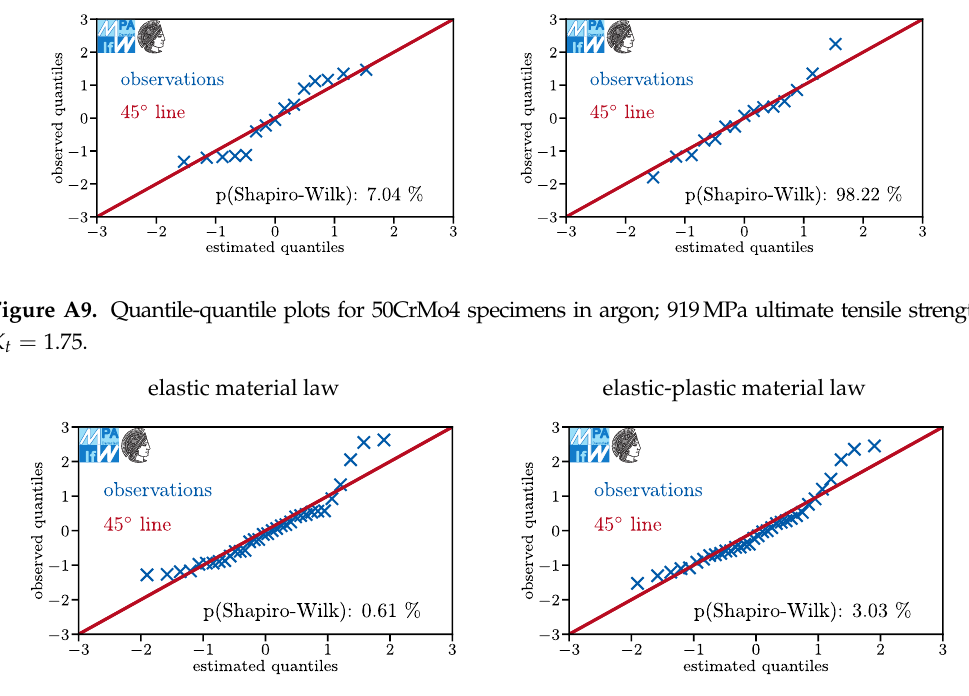
Figure A10. Quantile-quantile plots for 50CrMo4 specimens in laboratory air; 919MPa ultimate tensile strength; K t = 2.06.